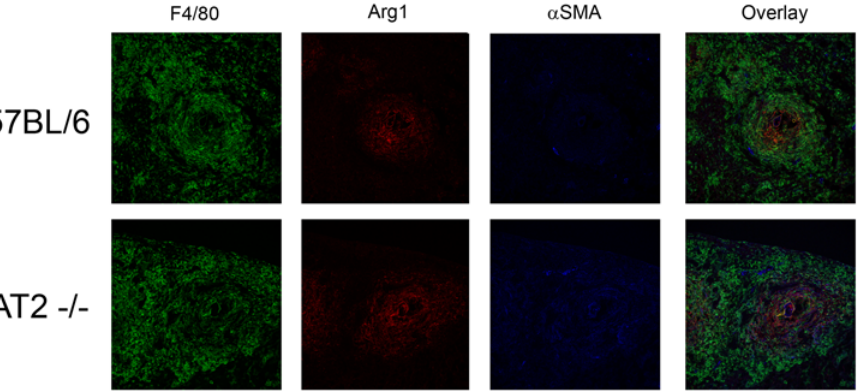
Figure 9. Arg-1 and a -SMA expression colocalized in CAT2 2 / 2 liver granulomas. C57BL/6 and CAT2 2 / 2 mice were infected percutaneously with S. mansoni for 10 weeks. Portions of livers were removed and frozen. 8 m M liver sections from C57BL/6 and CAT2 2 / 2 mice were stained anti-F4/ 80-Alexa 488 (Green), anti-Arg1-Alexa 647(Red), and anti-Alpha Smooth Muscle Actin-Texas Red (Blue). Individual 20 6 images were taken for each channel and then combined to provide a composite image. Images are representative of 3 individual mice from independent